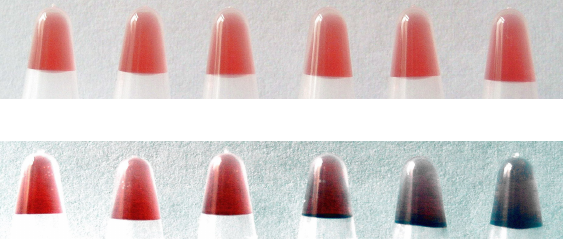
Figure 3. Salt-resistance for AuNPs from method II (top) and method I (bottom).(From left to right: addition of 0, 5, 10, 15, 20, 25 µ l of 0.1 M